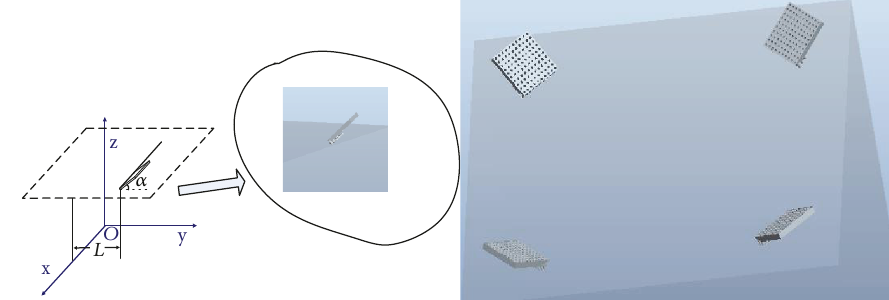
Figure 3: Array included